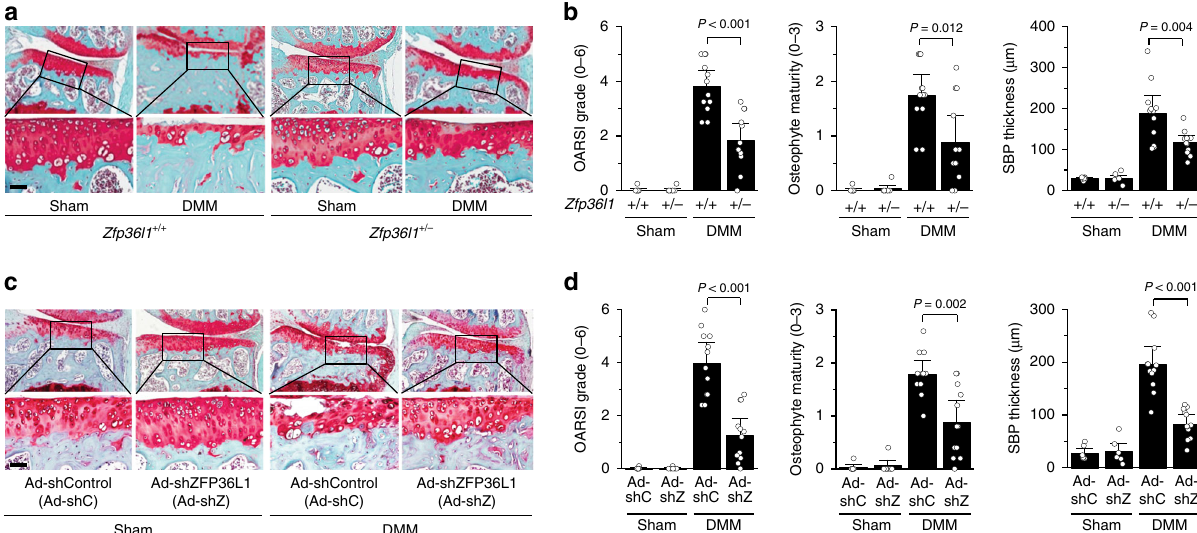
Fig. 3 Genetic ablation or silencing of Zfp36l1 abrogates OA pathogenesis in mice. a , b WT ( Zfp36l1 + / + ) and Zfp36l1 + / − mice were subjected to sham operation ( n = 7 mice per group) or DMM surgery ( n = 12 mice per group). Representative Safranin-O staining images ( a ) and scoring of OARSI grade, osteophyte maturity, and subchondral bone plate thickness ( b ). c , d Sham-operated ( n = 6 mice per group) or DMM-operated ( n = 12 mice per group) WT mice were IA injected with Ad-shC as a control or Ad-shZFP36L1 to knock down ZFP36L1 in the joint tissues. Representative Safranin-O staining images of joint sections ( c ) and scoring of OARSI grade, osteophyte maturity, and subchondral bone plate thickness ( d ). Means ± 95% CI with Mann – Whitney U test for OARSI grade and osteophyte maturity. Means ± s.e.m. with two-tailed t -test for SBP thickness. SBP subchondral bone plate. Scale bar: 50 μ